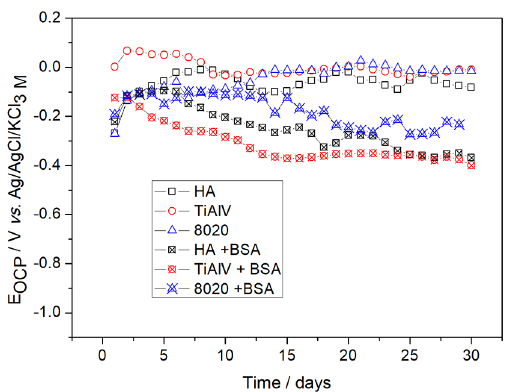
Figure 1. Open circuit potential vs. time curves for studied samples in non-deaerated and unstirred Hanks' solution at 37 ºC, with and without BSA for 30 days of